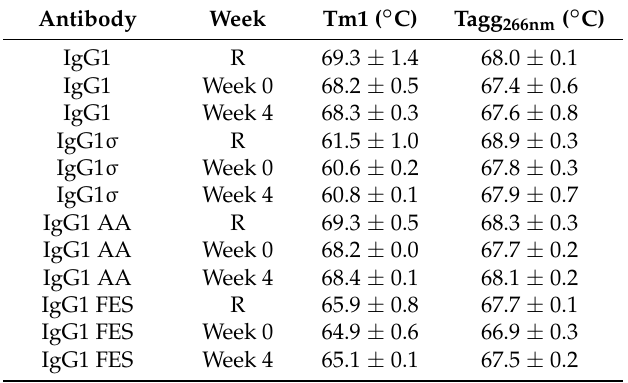
Table 5. Tm and temperature of aggregation (Tagg) of Fc variants at high concentration (40–50